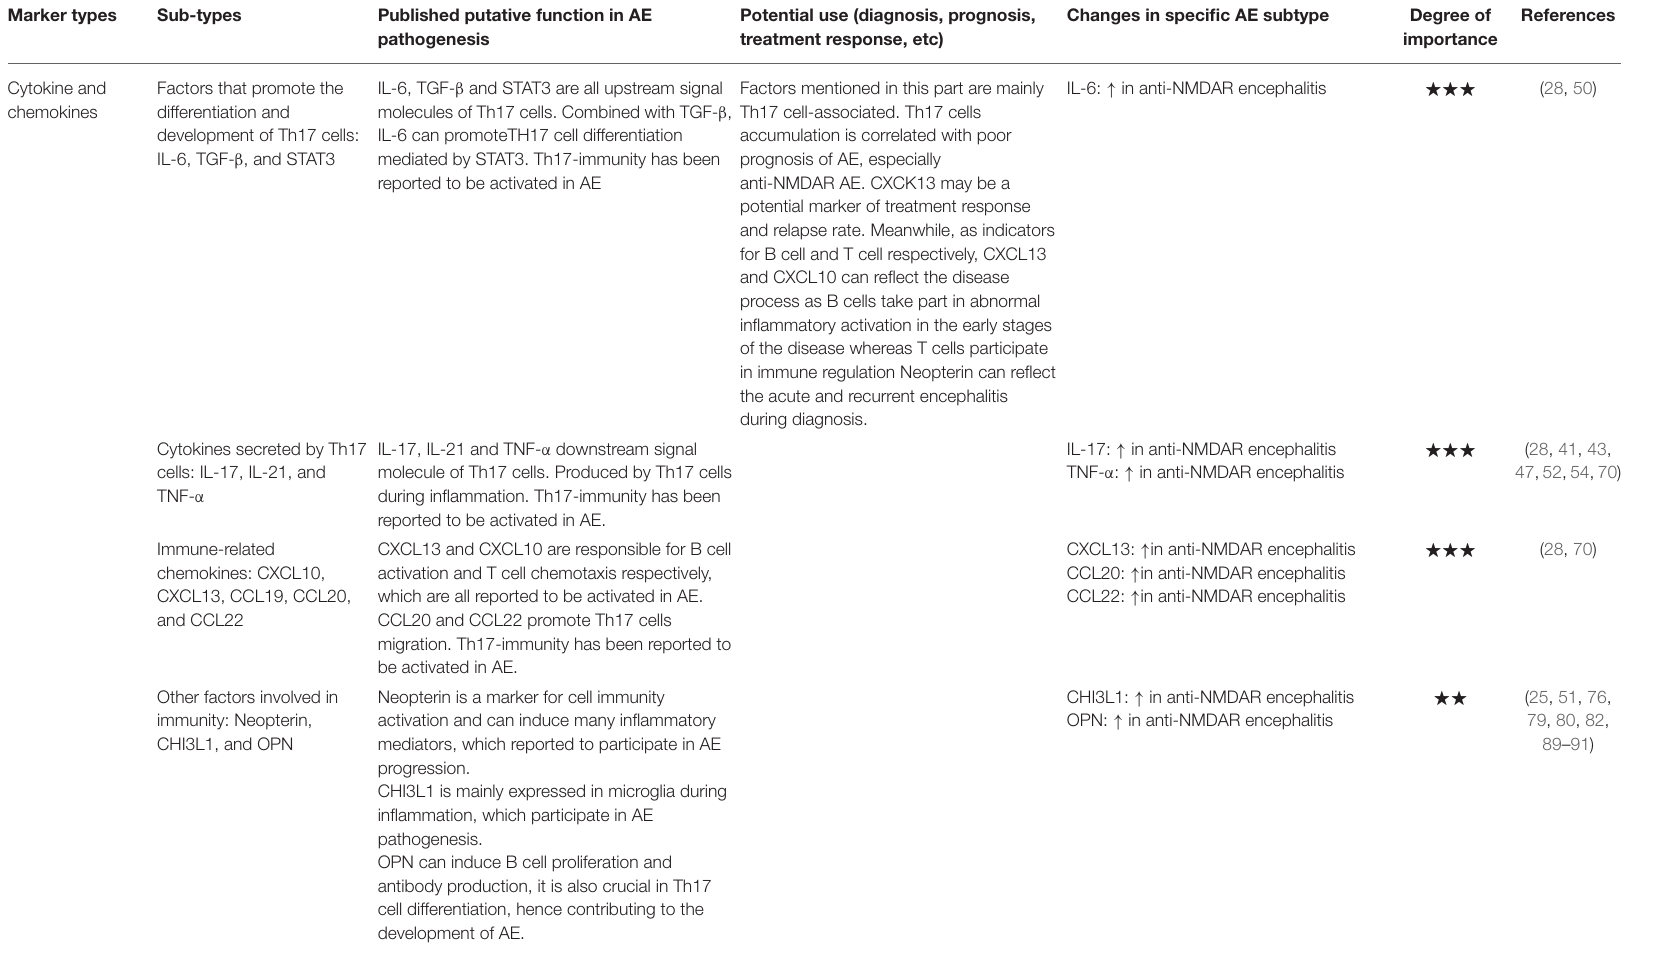
TABLE 1 | Concise summary of potential AE